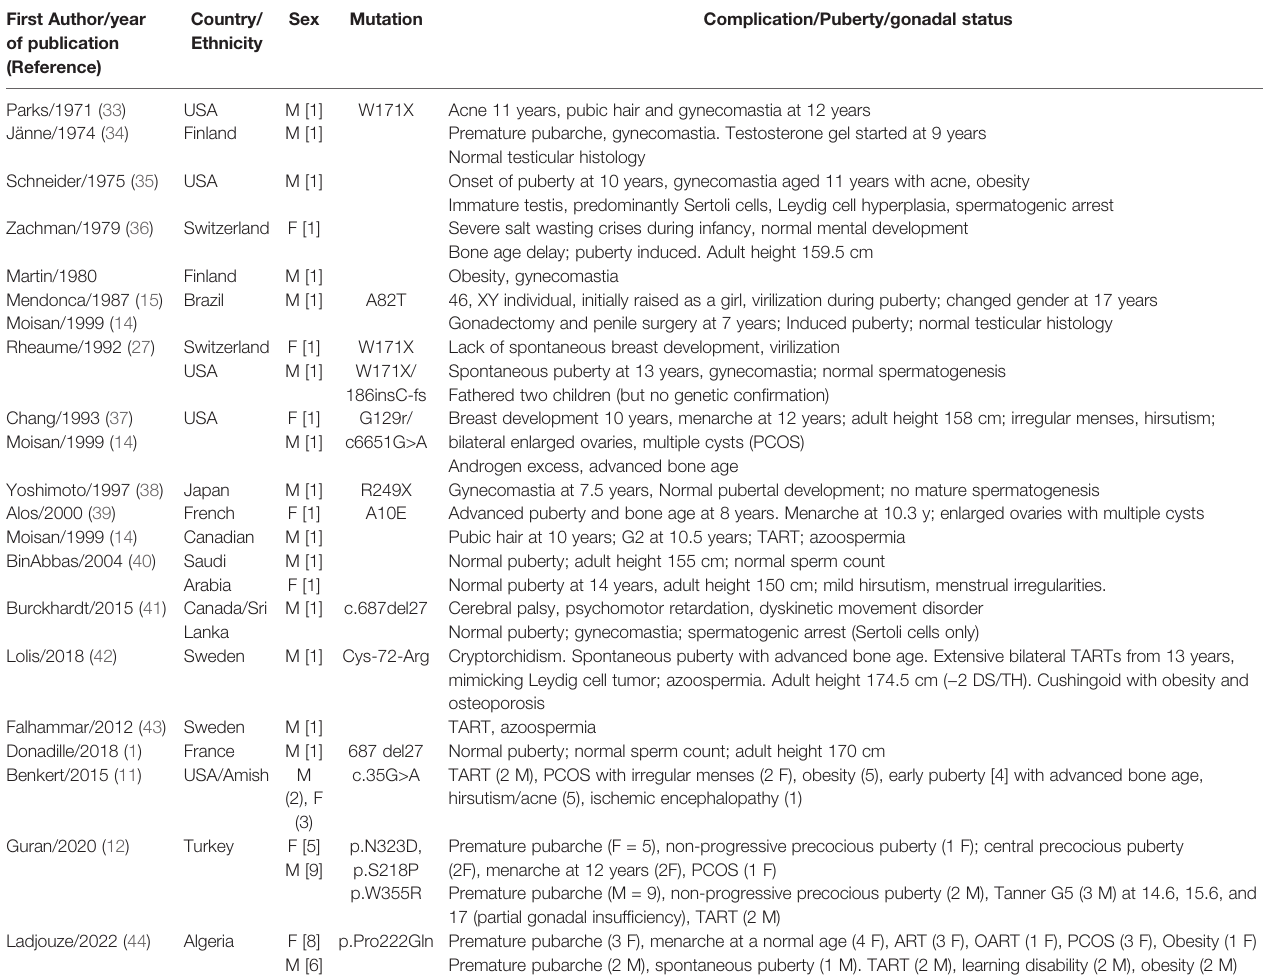
TABLE 4 | Studies showing outcomes in patients with 3- b hydroxysteroid dehydrogenase 2 de fi